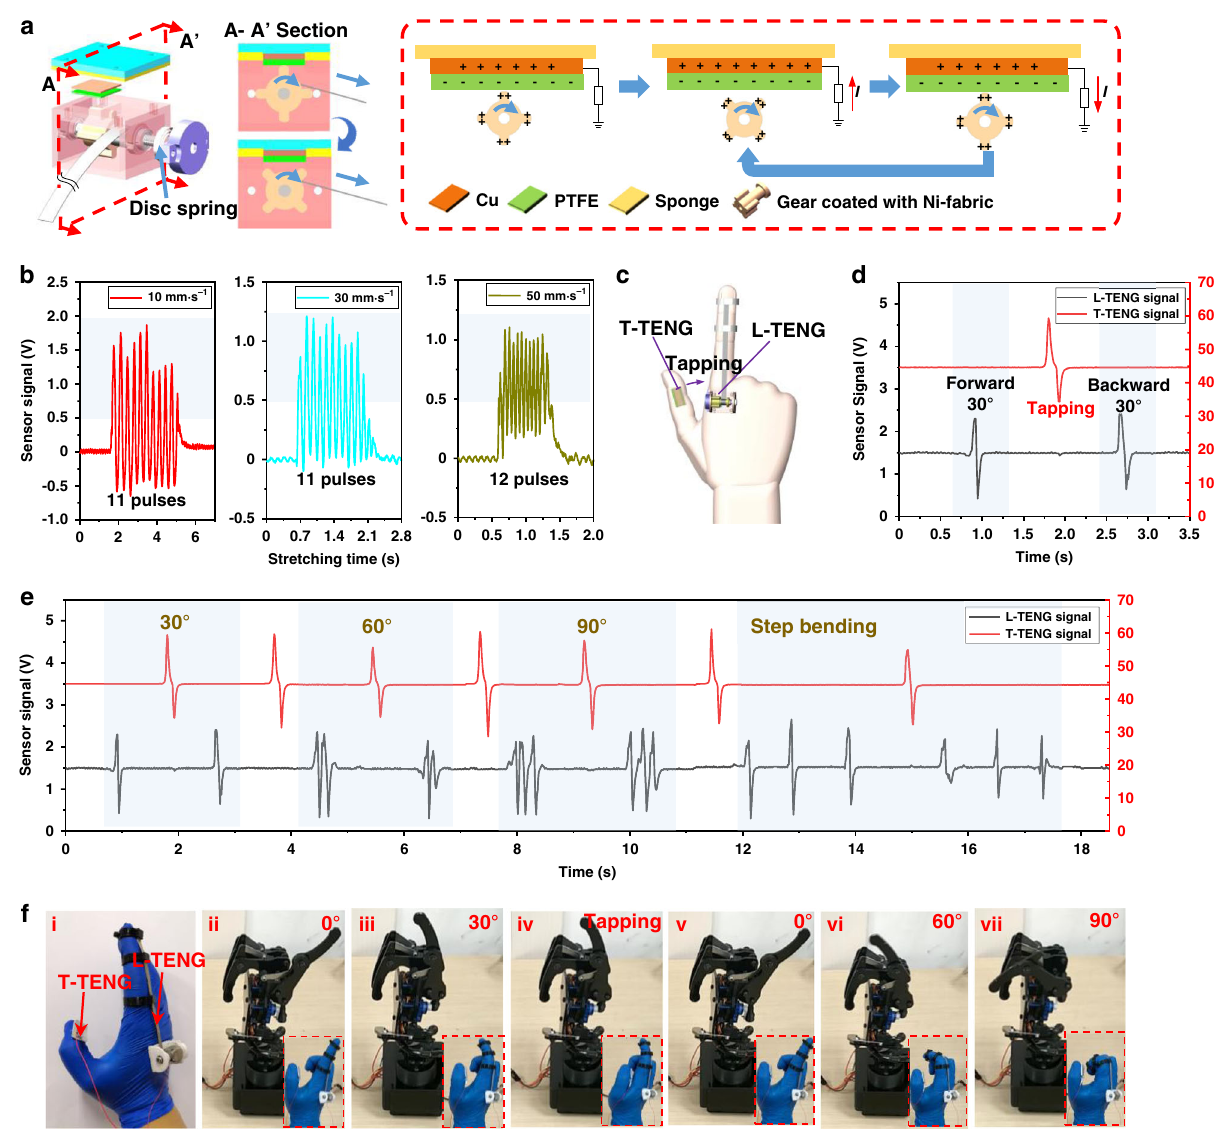
Fig. 3 Working mechanism of the length TENG (L-TENG) sensor and the real-time veri fi cation in HMIs. a Working mechanism of L-TENG sensor. b Stretching output of the L-TENG sensor at various speeds. c The photograph of the HMIs with L-TENG sensor and tactile TENG (T-TENG) sensor integrated on a nitrile glove. d The real-time signals when the robotic hand is controlled to bend to 30° and return to its original position. e The real-time signals of controlling the robotic fi nger to bend to different angles in one-step mode and step-by-step mode. f The photographs of the actual hand gestures and their corresponding robotic hand motions. (i) The nitrile glove with sensors. (ii – v) The robotic hand deforms to 30° and returns to 0°. (vi, vii) The robotic hand with 60°, 90°